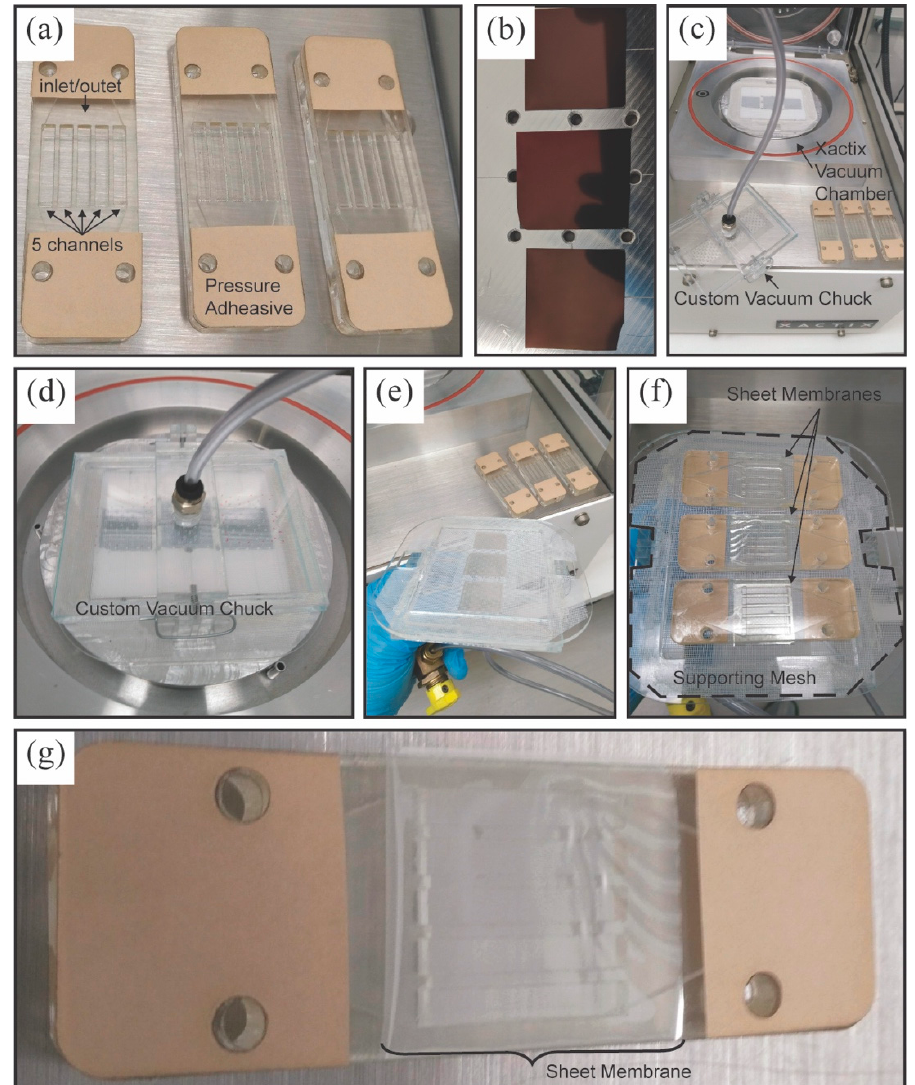
Figure 2. Sheet membrane fabrication process. ( a ) Assembled device halves ready for membrane transfer. ( b ) Loading three ~ 1” × 1” samples of nanoporous silicon nitride membrane wafers prior